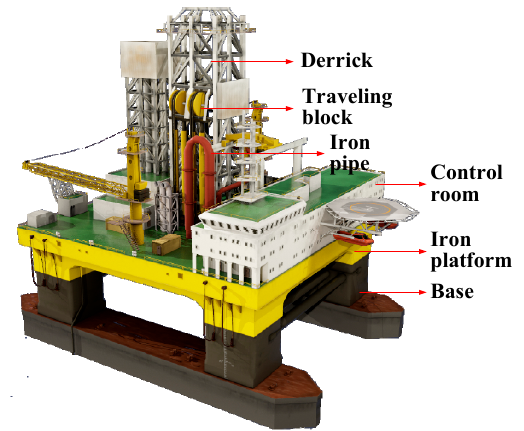
Figure 3. Oil drilling